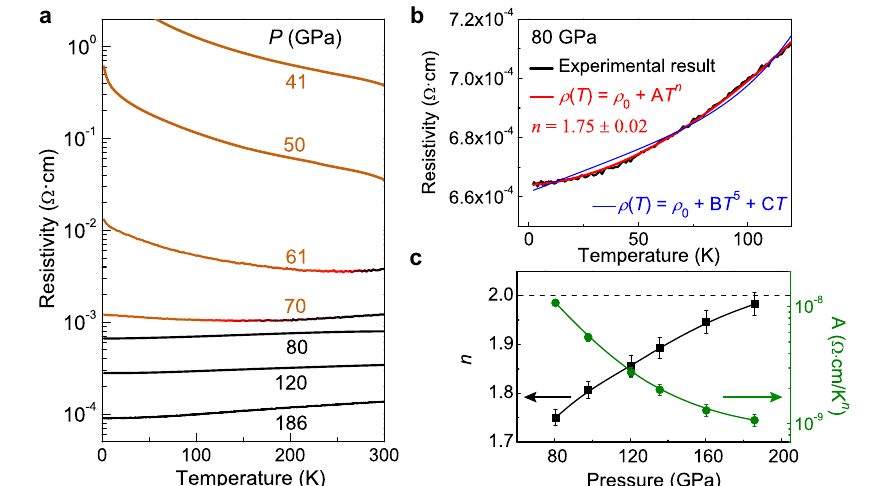
Fig. 2 | Low-temperature electrical transport properties of CsPbI 3 at high pressure. a Resistivity – temperature ( ρ – T ) curves at representative pressures ( P ) showing the insulating-semimetallic-metallic transition in compressed CsPbI 3 . The orange and black lines represent the insulating and metallic phases, respectively. The red lines in 61 and 70GPa mark the transition temperatures where d ρ /d T